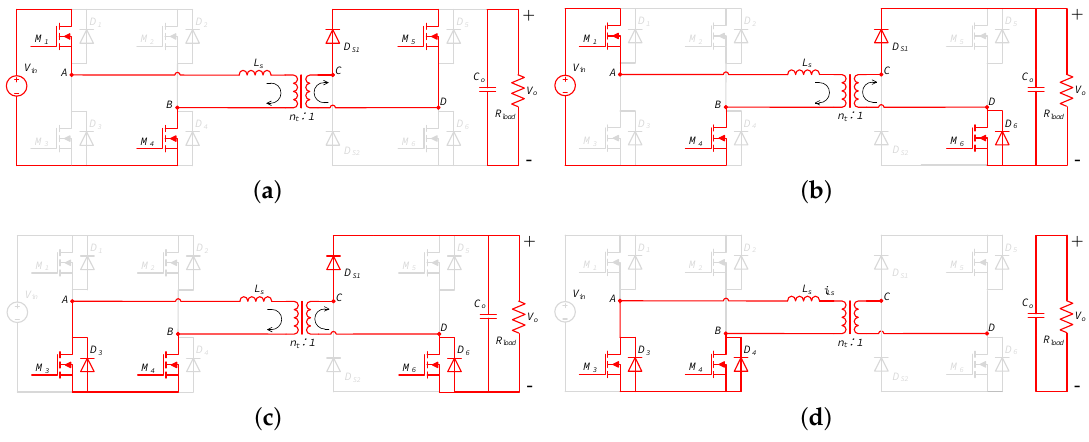
Interval 4 [Figure 5d]: After γ − α , all secondary diodes are reversed biased, which will result in the secondary-side of transformer being open-circuited. Meanwhile, the primary switches M 3 and M 4 are still conducting. Thus, the transformer secondary voltage is clamped at 0, and i Ls is kept at zero. This interval ends up with M 2 turned on at zero current. In this zero-current interval, there is no power transferring in the converter.